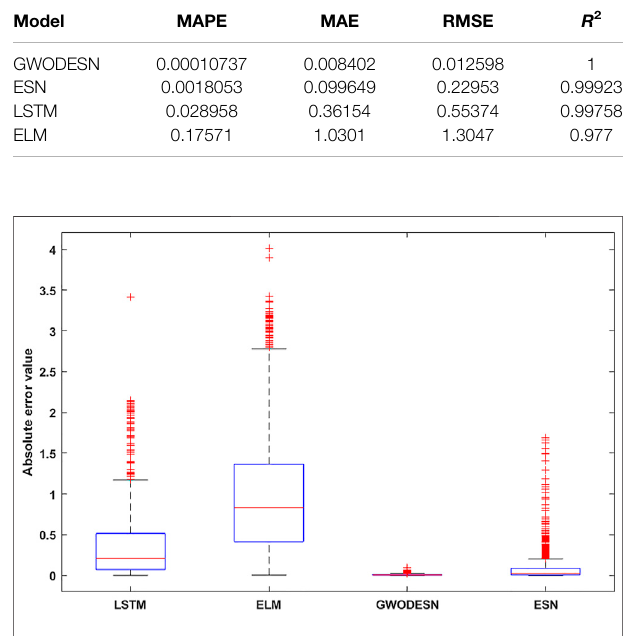
FIGURE 4 | The absolute error box diagram for Lorenz x( t ).